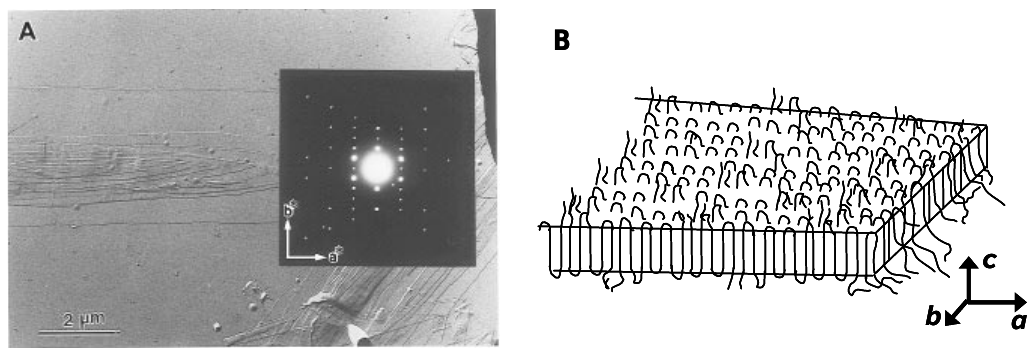
Figure 3. Morphology and crystalline structure of P(3HB) single crystals. (A) Electron micrographs of P(3HB) single crystals. (B) Schematic model of molecular chain packing